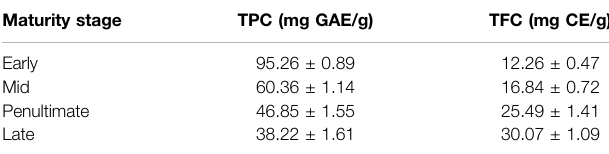
TABLE 2| Phenolic and fl avonoid compositionof M.oleifera leaf extractat thelate stage. Phenolics and fl